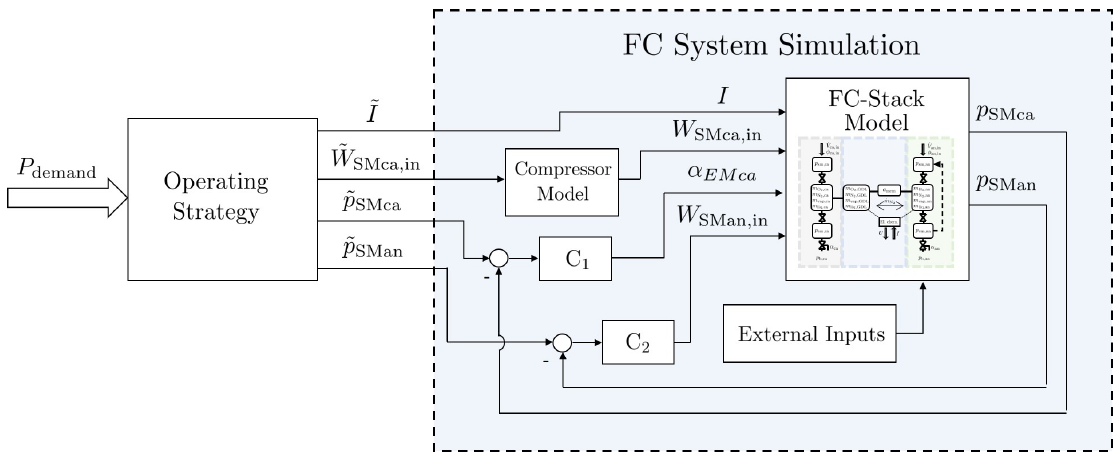
Figure 4. Schematic of the FC System simulation. C 1 denotes the feedback controller responsible for the actuation of the backpressure valve. The controller C 2 determines the injection of